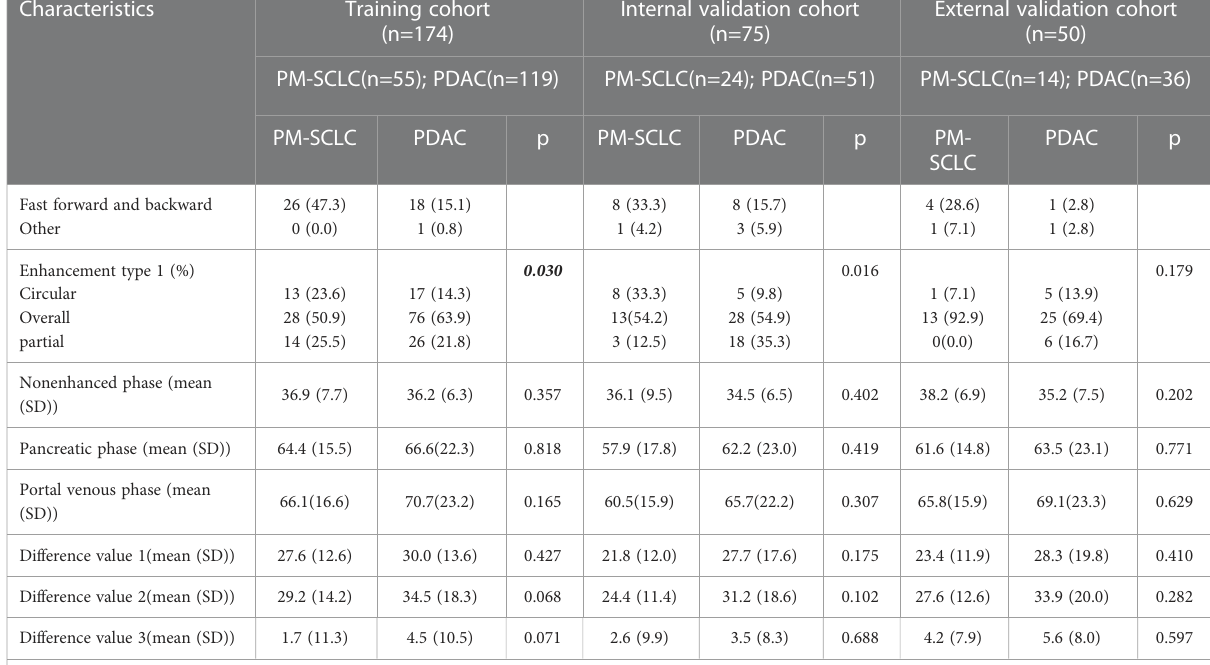
TABLE 3 Three clinical characteristics and biomarkers for PM-SCLC diagnosis in multivariate logistic regression analysis. variables OR Clinical